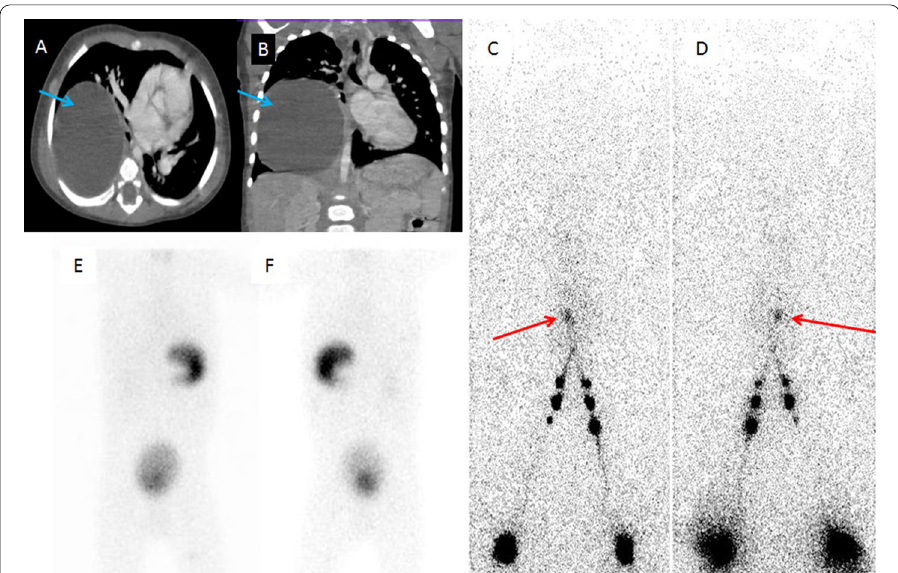
Fig. 1 Transaxial and coronal preoperative CT image showing the oval to round shaped large cystic lesion (A,B). Anterior (C) and posterior (D) whole body images acquired 30 min post intradermal injection of filtered Tc99m sulphur colloid in the the first interdigital webs of bilateral lower limbs. Focal accumulation of radiotracer seen in the right lower hemithorax region (as shown by red arrow). No abnormal foci of radiotracer uptake seen in the neck and thorax region on anterior (E) and posterior (F) images acquired after ointravenous injection of 2 mCi of Tc99m pertechnetate to suggest heterotrophic gastric mucosa. Tc99m pertechnetate images were acquired after 48 h of Tc99m sulphur colloid